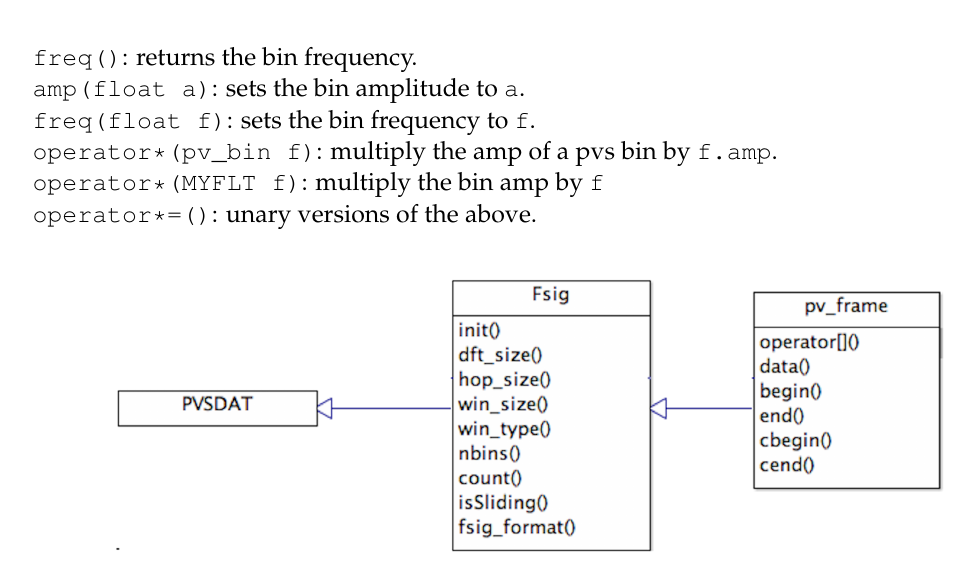
Figure 3. The Fsig and pv_frame classes and their relationship to the opaque C structure PVSDAT